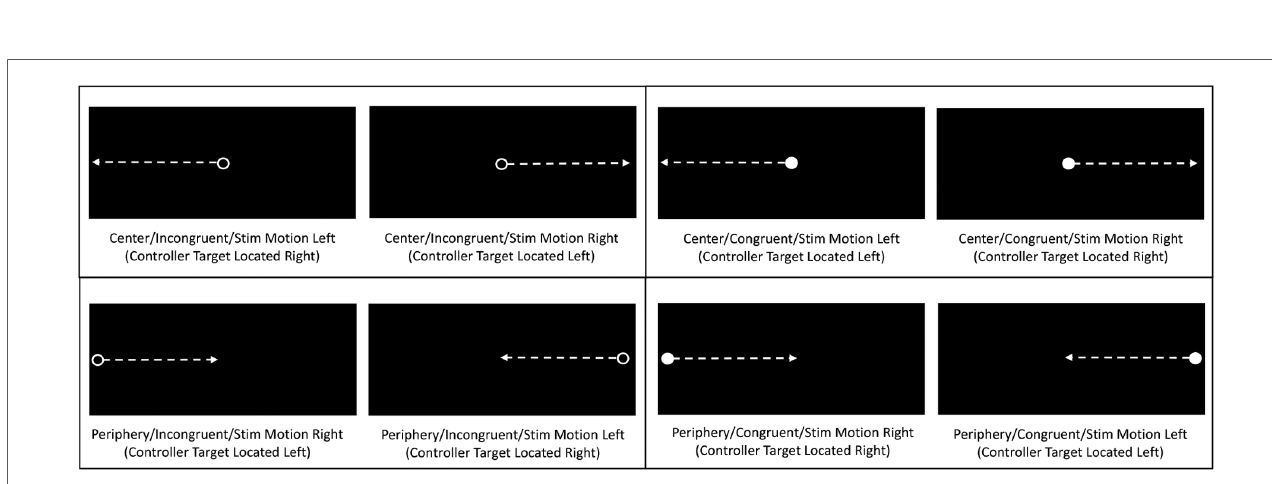
FIGURE 2 Depictions of head-mounted display views of horizontally moving circles, with arrows representing circle movement directions. Each panel depicts a unique combination of initial moving circle location (center versus periphery) and type (open/incongruent versus solid/congruent). Determination of stimulus type and movement direction required to locate correct response